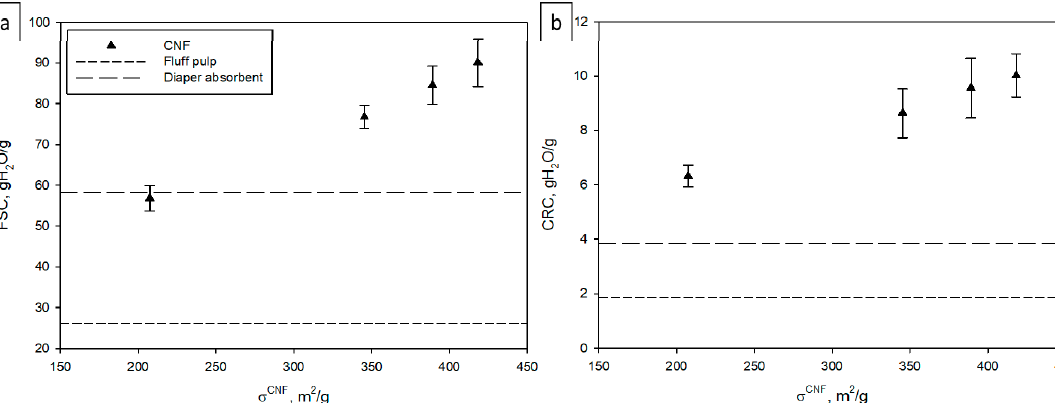
Figure 5. Evolution of free swelling capacity (FSC) as a function of immersion time (in minutes).